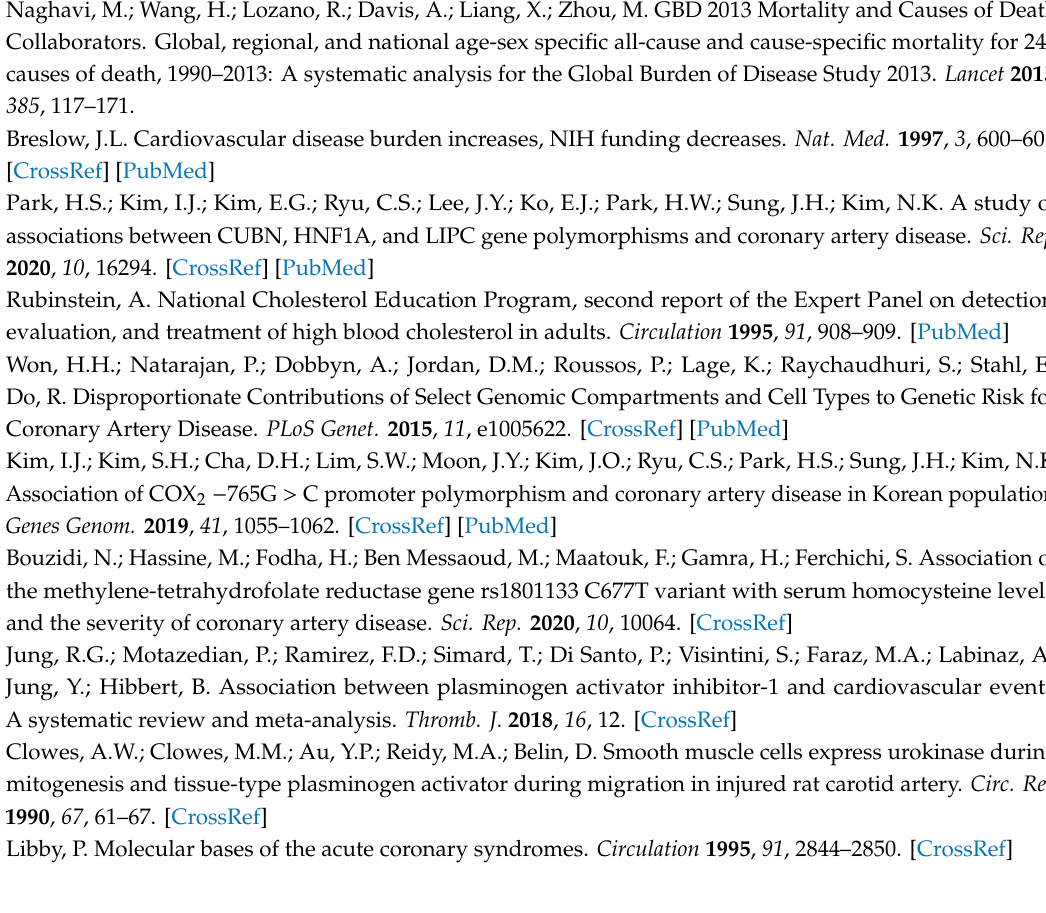
Table S1: Synergic e ff ect of PAI-1 polymorphisms with clinical risk factor, Table S2: Information of PAI-1 polymorphism for PCR-RFLP